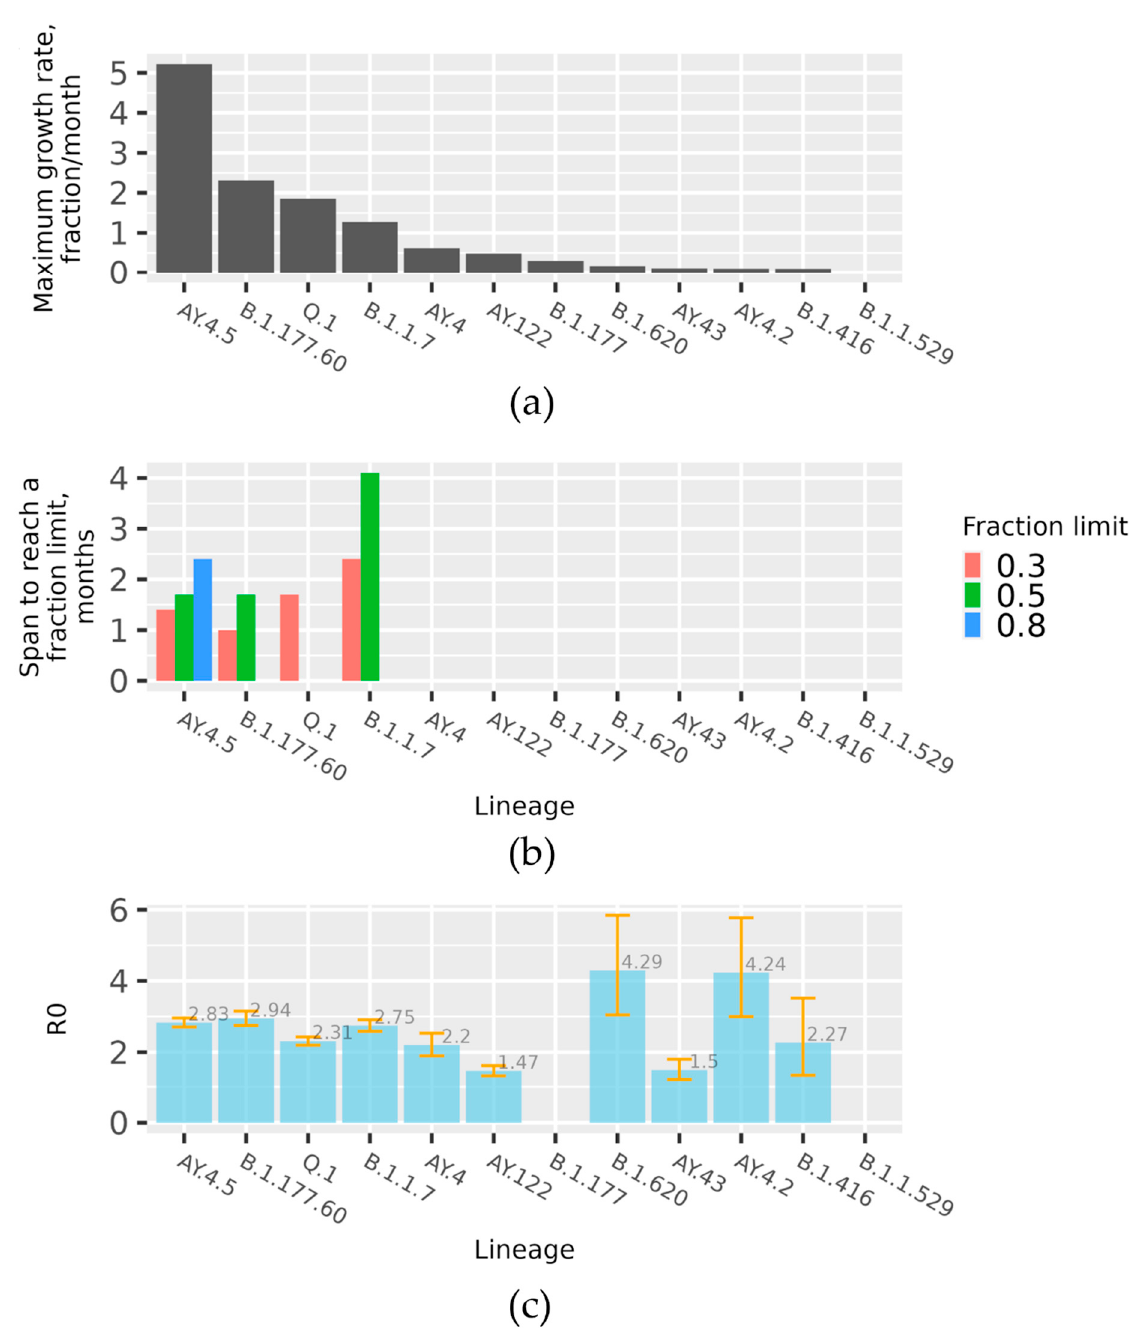
Figure 3. The fastest spreading lineages. The data represent lineages with more than 100 Lithuanian sequences in GISAID. The data presented in ( a , b ) are based on spline interpolation of observed month fractions of all GISAID-deposited Lithuanian sequences. ( a ) Plot indicates the maximum first order derivative of the spline fitted to the month fractions of each lineage. ( b ) Plot indicates the time spans required to reach a certain fraction limit of all GISAID-deposited Lithuanian sequences (indicated by fill colour). ( c ) The plot represents calculated R0 values for the lineages based on the absolute number of corresponding lineages aggregated on a monthly basis. For some lineages, it was impossible to calculate R0 values, and they are not given.